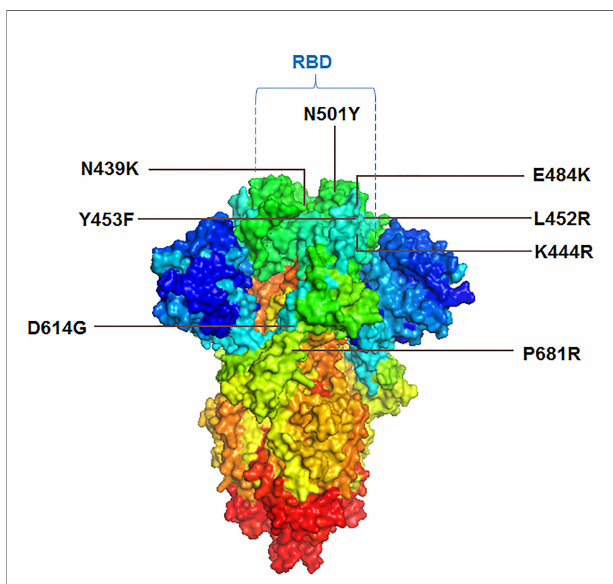
FIGURE 5 | 3D model of S-glycoprotein illustrating the location of signi fi cant mutations in the variants, associated with immunity